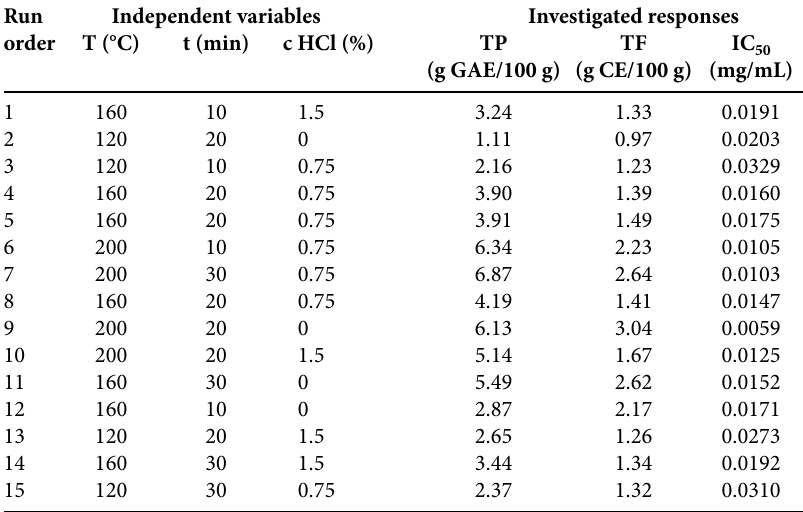
Table 2. Natural values of independent variables for Box-Behnken design and experimentally ob- served responses (TP, TF, IC 50 ) in obtained extracts Run Independent variables Investigated